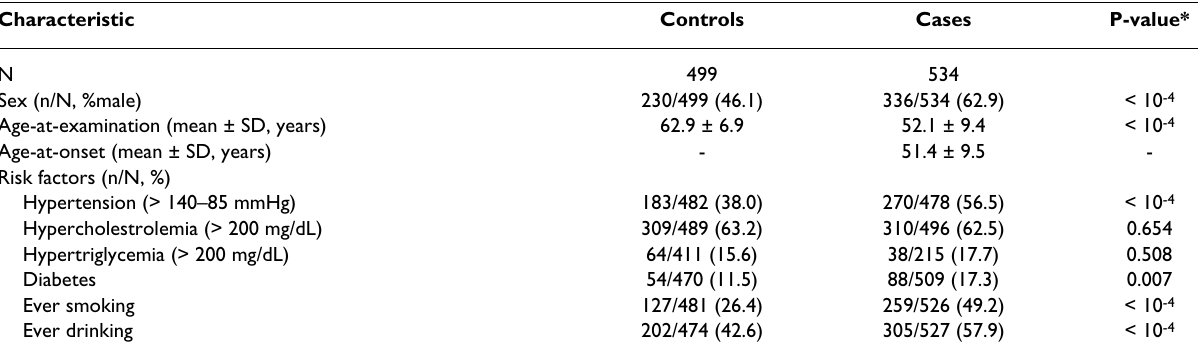
Table 2: General characteristics of the ischemic stroke case-control study sample